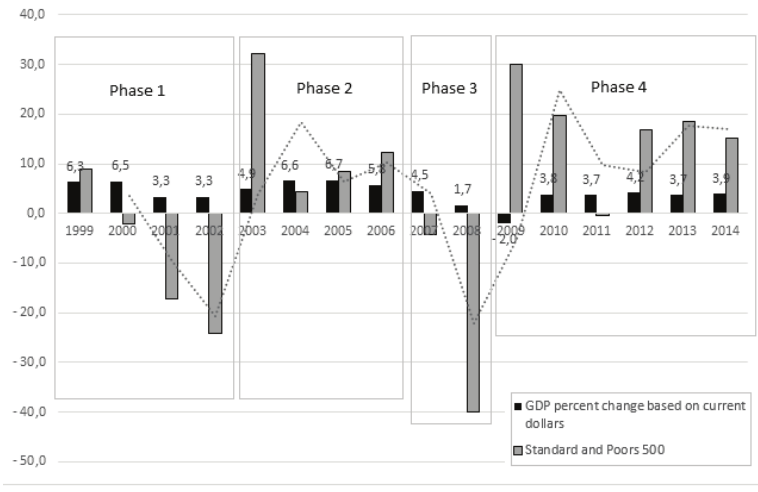
Fig. 3 – US GDP and Standard and Poor´s Index % change in current dollars. Source: own calculations and